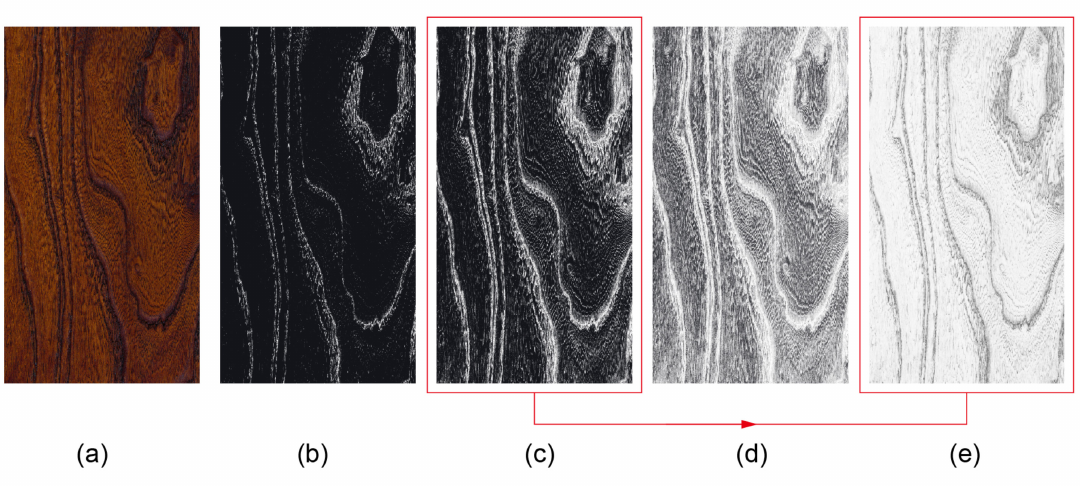
Figure 5. ( a ) An original, RGB scanning image of an elm board sample. ( b ) Grayscale image: fuzziness parameters 50. ( c ) Grayscale image: fuzziness parameters 100. ( d ) Grayscale image: fuzziness parameters 150. ( e ) White spot channel e ff ect.